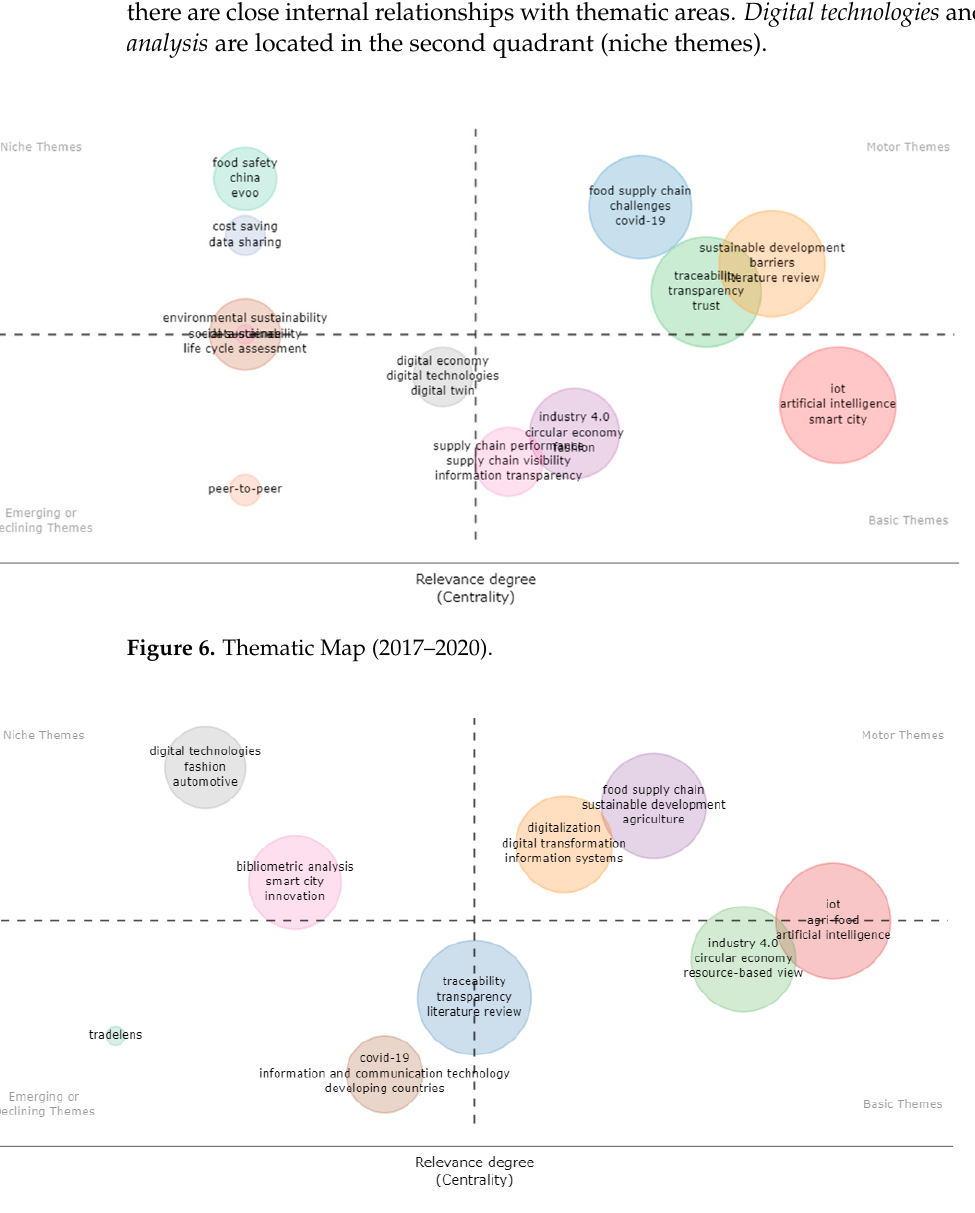
Figure 7. Thematic Map (2021).